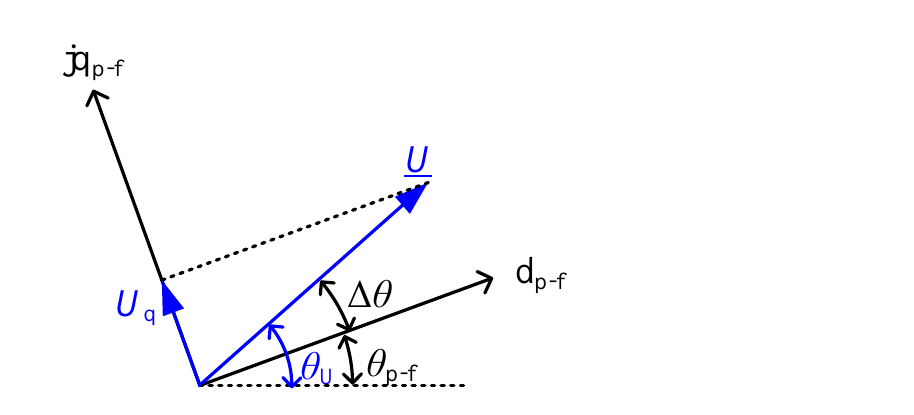
Figure 13. The terminal voltage vector 𝑈 in the synchronous rotation coordinates of the P-f loop.